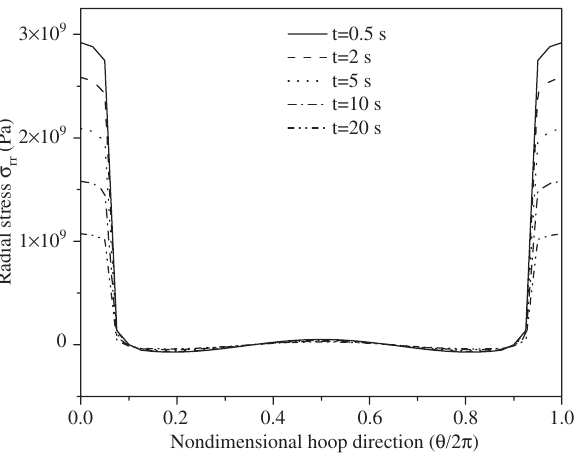
Figure 22 Distributions of tangential stress along the hoop direc- tion of the FGM hollow cylinder at different times.